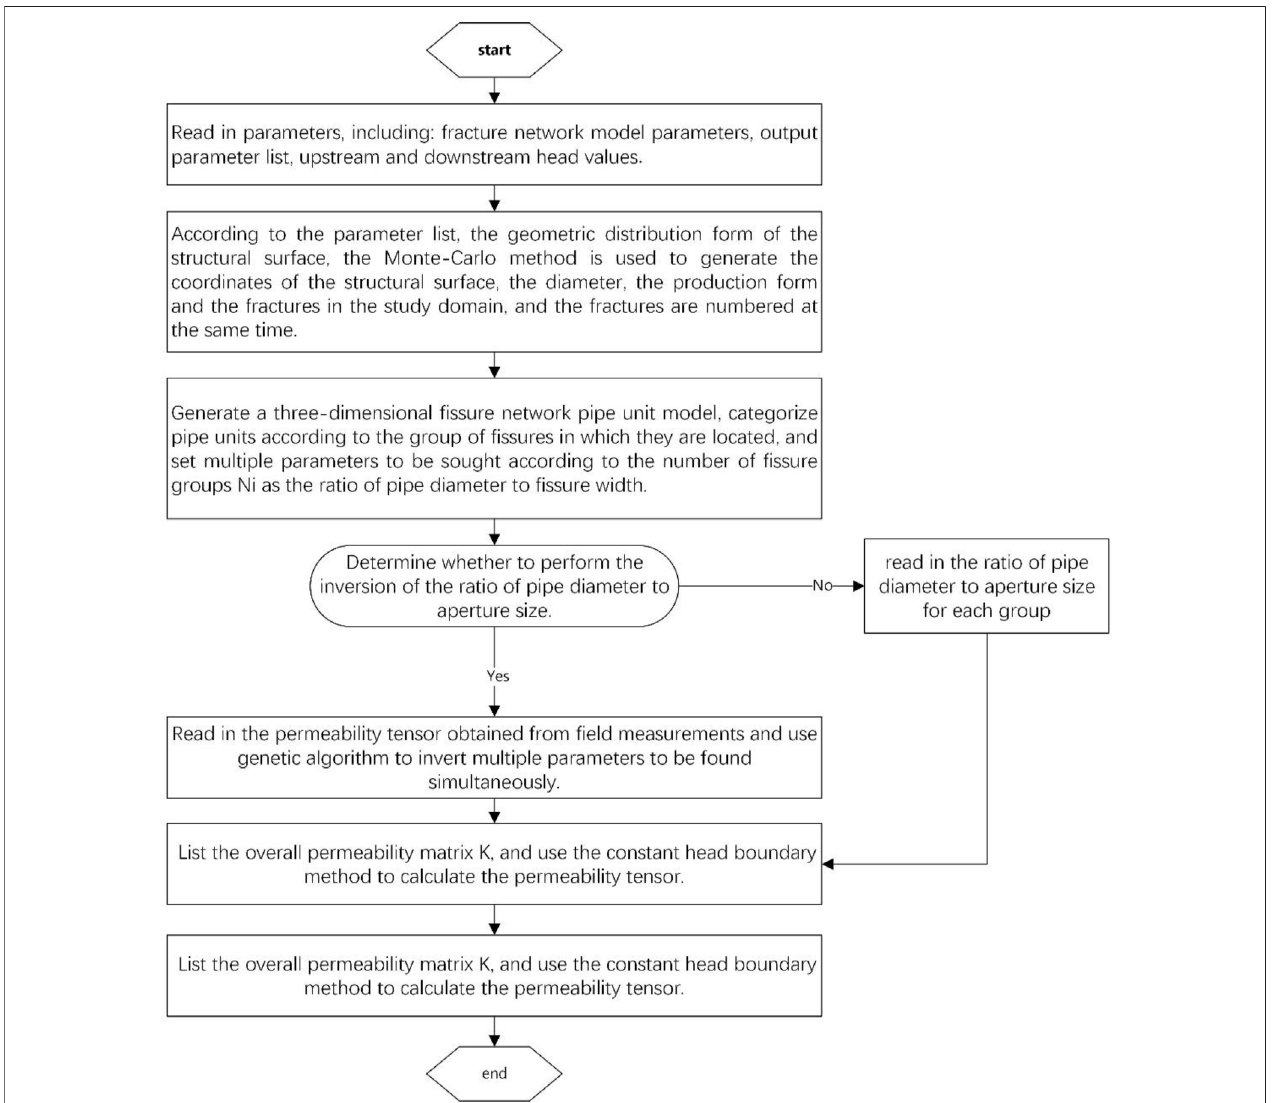
FIGURE 4 | Calculation fl